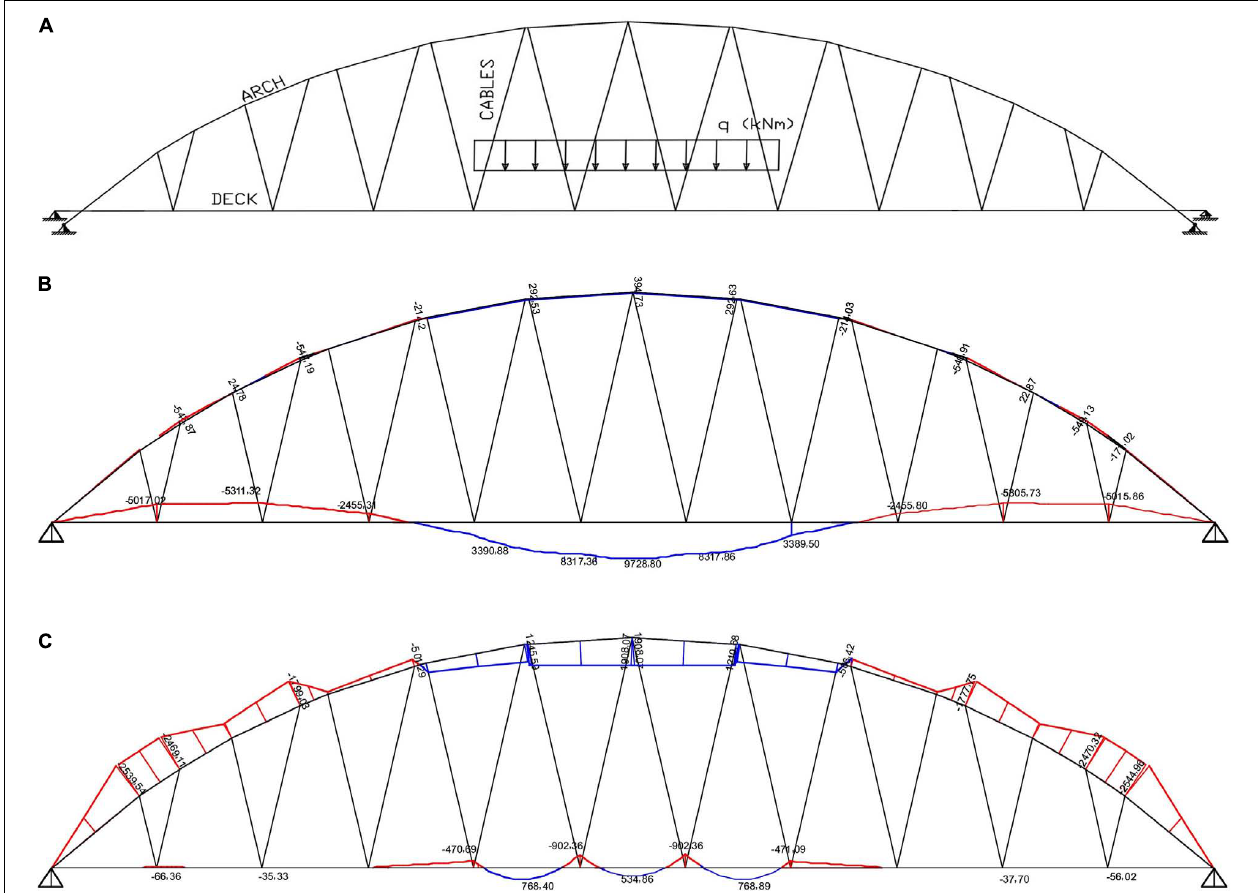
FIGURE 7 | Numerical results for load case 2. (A) Load case 2: action of a PUDL over three central segments of the deck. (B) BMD over the deck and the arch under zero cable pre-tension forces. (C) TBMD produced by the optimal cable pre-tension forces.